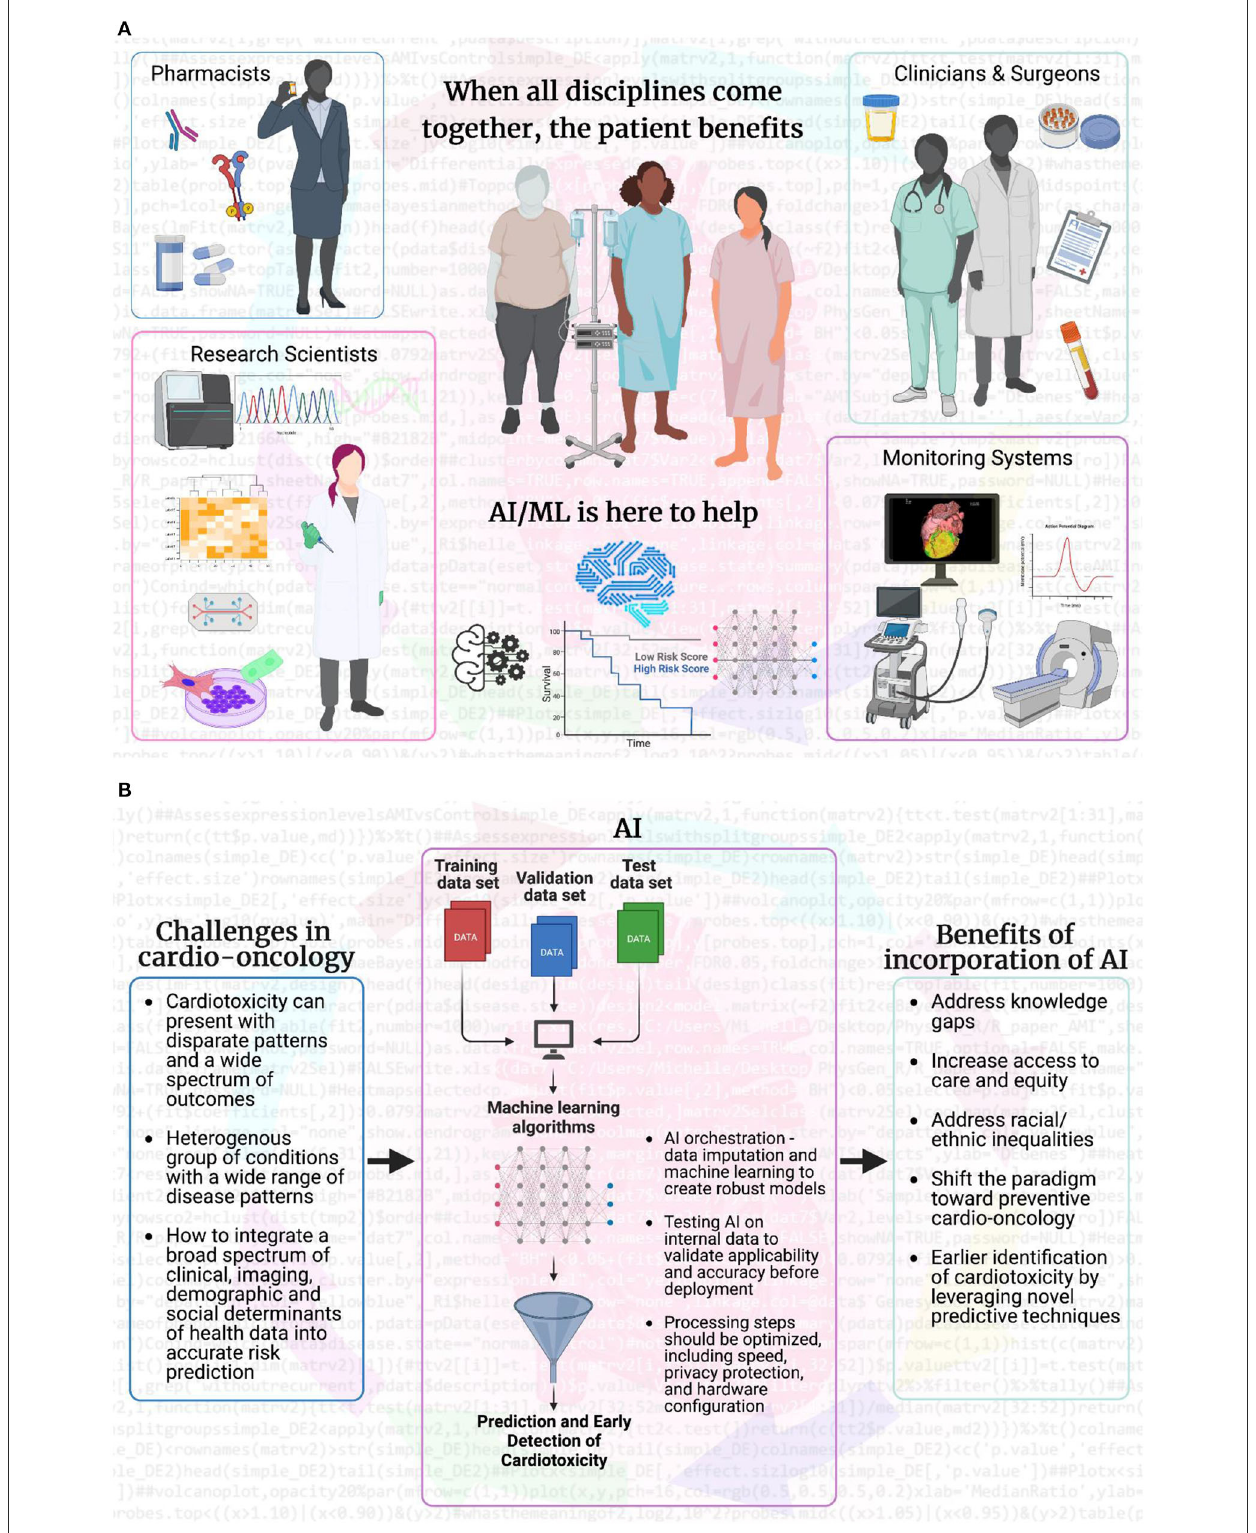
FIGURE1 Artificial intelligence and machine learning bridge gaps to make patient care more effective. (A) AI and ML fuel scientific research by analyzing big data from multiple sources: individual patients, healthcare professionals (pharmacists, research scientists, clinicians, oncologists, surgeons, cardiologists, and advanced cardiovascular imaging experts), and imaging/monitoring systems (ultrasound, MRI, CT, PET, and electrophysiology). Clinicians and surgeons are at the forefront of health discussions and can access patient information and fresh or banked samples. AI/ML can analyze imaging beyond visual capabilities and integrate results into the decision-making process for pharmacists and scientists. Pharmacists can incorporate information on patient over-the-counter, pain management, and adherence to prescription medication into AI/ML systems. When combined with patient outcomes, AI/ML can achieve the goal of maximum treatment with minimal adverse effects, even years after treatment is complete. AI/ML